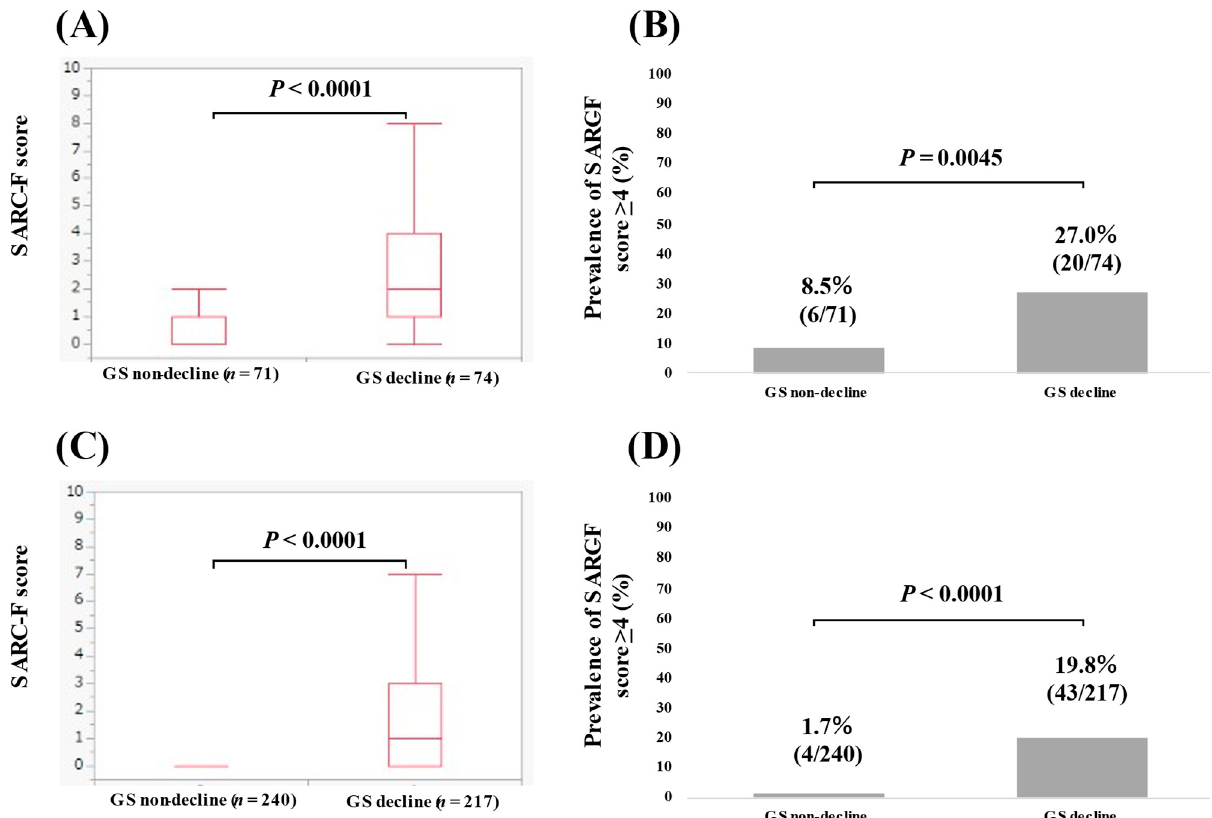
Figure 3. ( A ) The SARC-F score in patients with GS non-decline ( n = 71) and GS decline ( n = 74) (advanced cancer cases, n = 145). ( B ) The percentage of the SARC-F score ≥ 4 in patients with GS non- decline and GS decline (advanced cancer cases). ( C ) The SARC-F score in patients with GS non-decline ( n = 240) and GS decline ( n = 217) (non-advanced cancer cases, n = 457). ( D ) The percentage of the SARC-F score ≥ 4 in patients with GS non-decline and GS decline (non-advanced cancer cases).